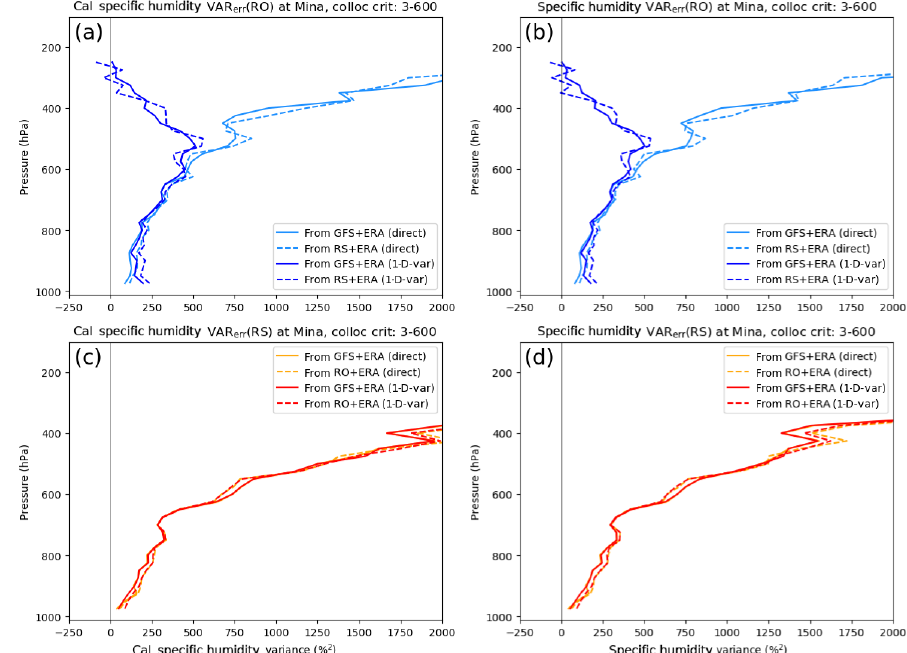
Figure A1. Estimated RO and RS error variances for specific humidity at Minamidait¯ojima (Japan) using calibrated data as in the TC method (a, c) and the uncalibrated data as in the 3CH method (b, d) . For the TC method, the RO, RS, and GFS data sets are calibrated with respect to ERA as the reference data set. The following combinations of the four data sets are used: (ERA, RO, RS), (ERA, RO, GFS), and (ERA, GFS, RS).